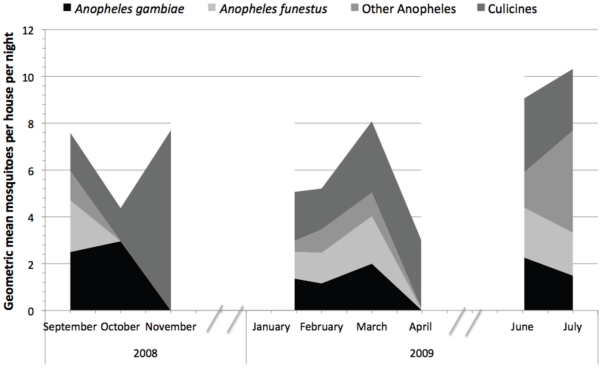
Geometric mean mosquitoes collected per night using CDC LT during the three sampling periods 1) September–November 2008; 2) January to April 2009; 3) June–July 2009.Areas are stacked to show how the relative composition of mosquitoes changes through time.